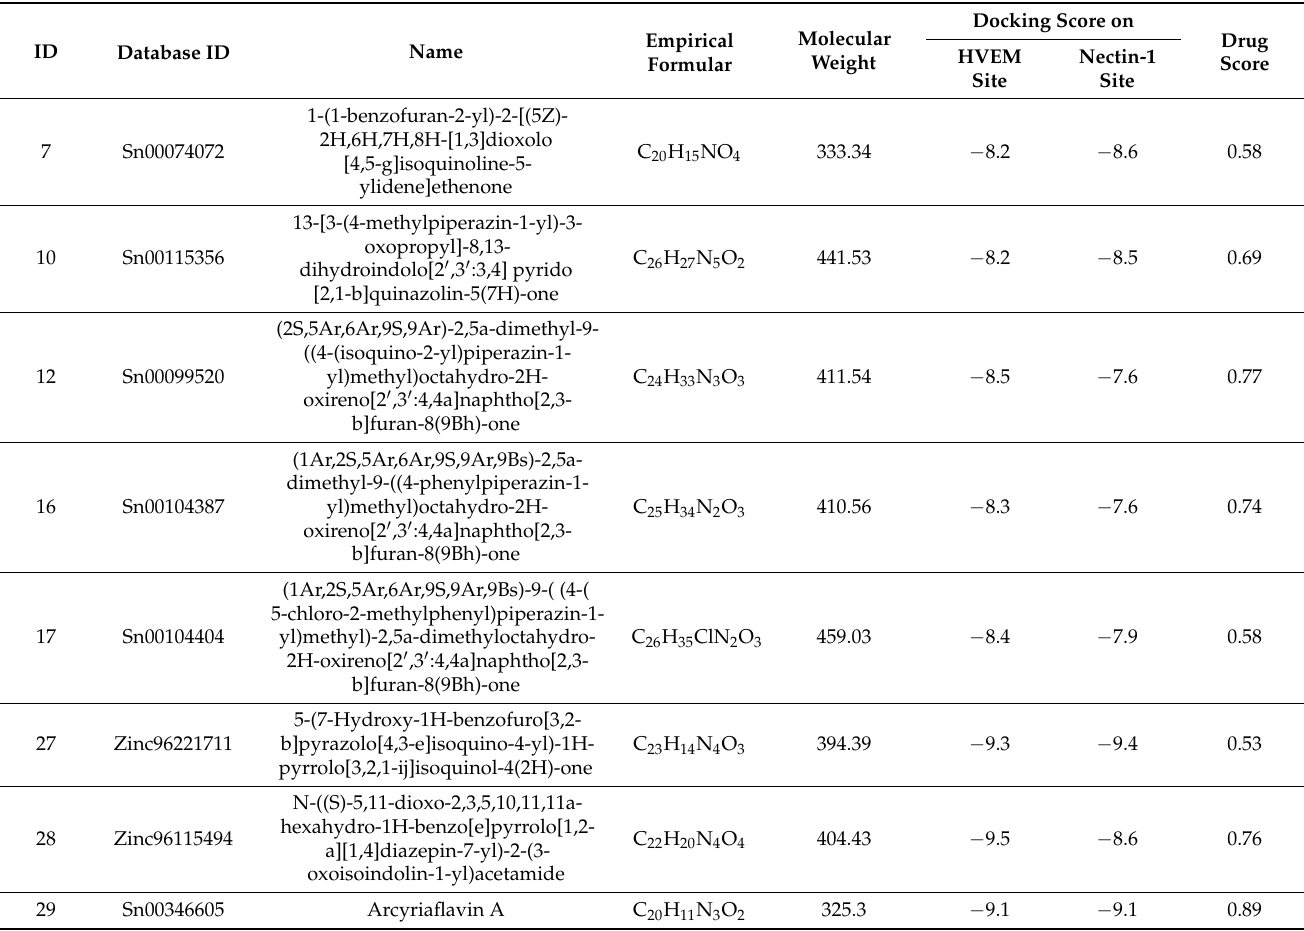
Table 1. List of compounds selected for in vitro validation based on in silico predictions on the (herpes virus entry mediator) HVEM and nectin-1 binding interfaces of glycoprotein